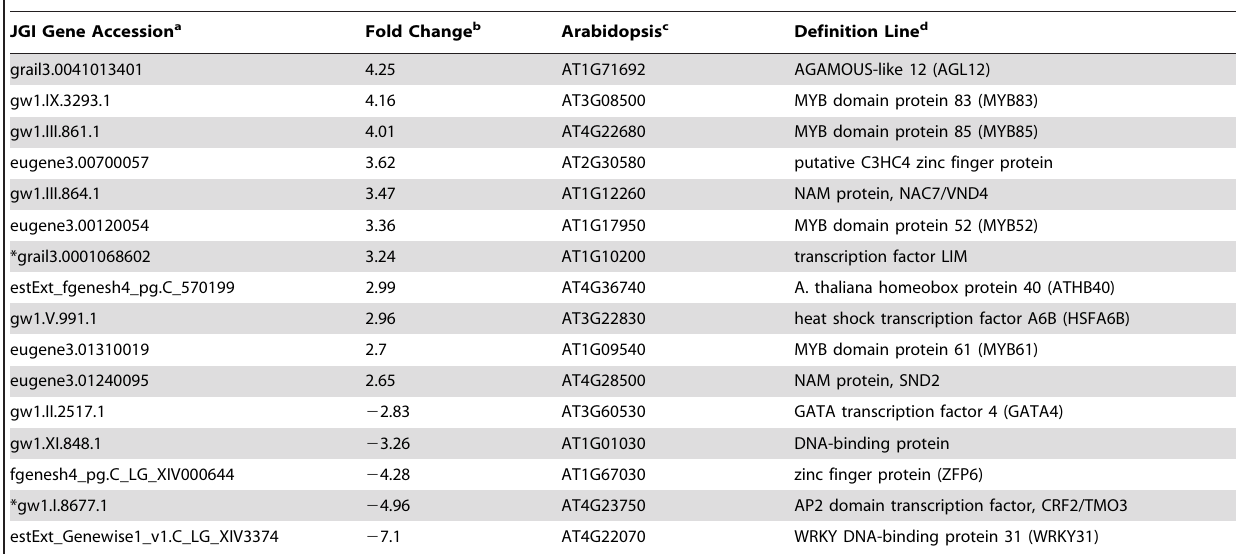
Table 1. Transcription factors mis-regulated in PCN transgenics.